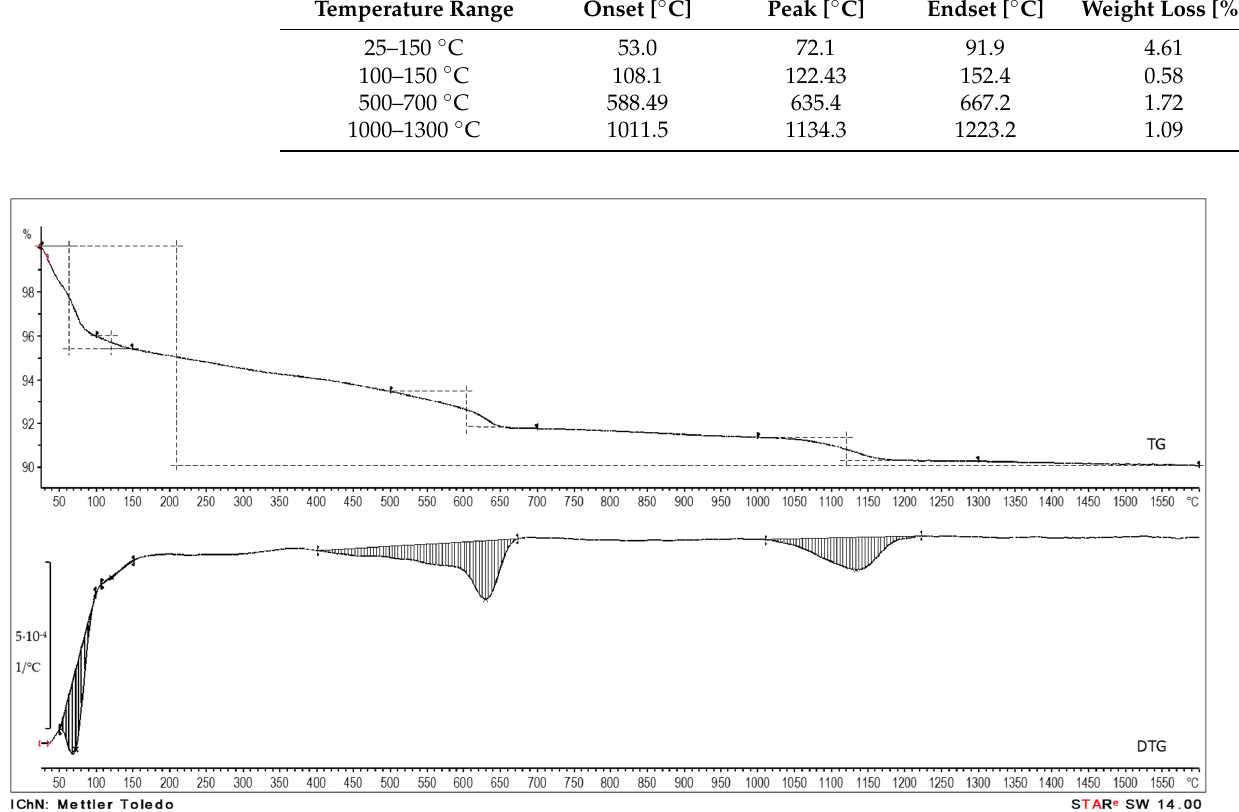
Figure 8. MSWIBA